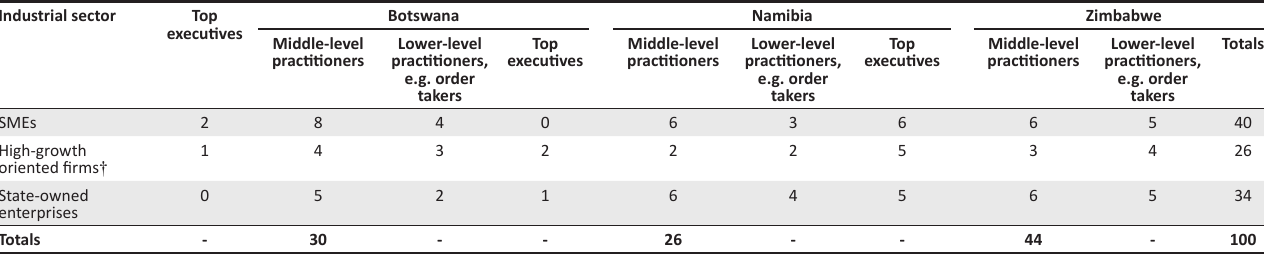
TABLE 1: Characteristics of the